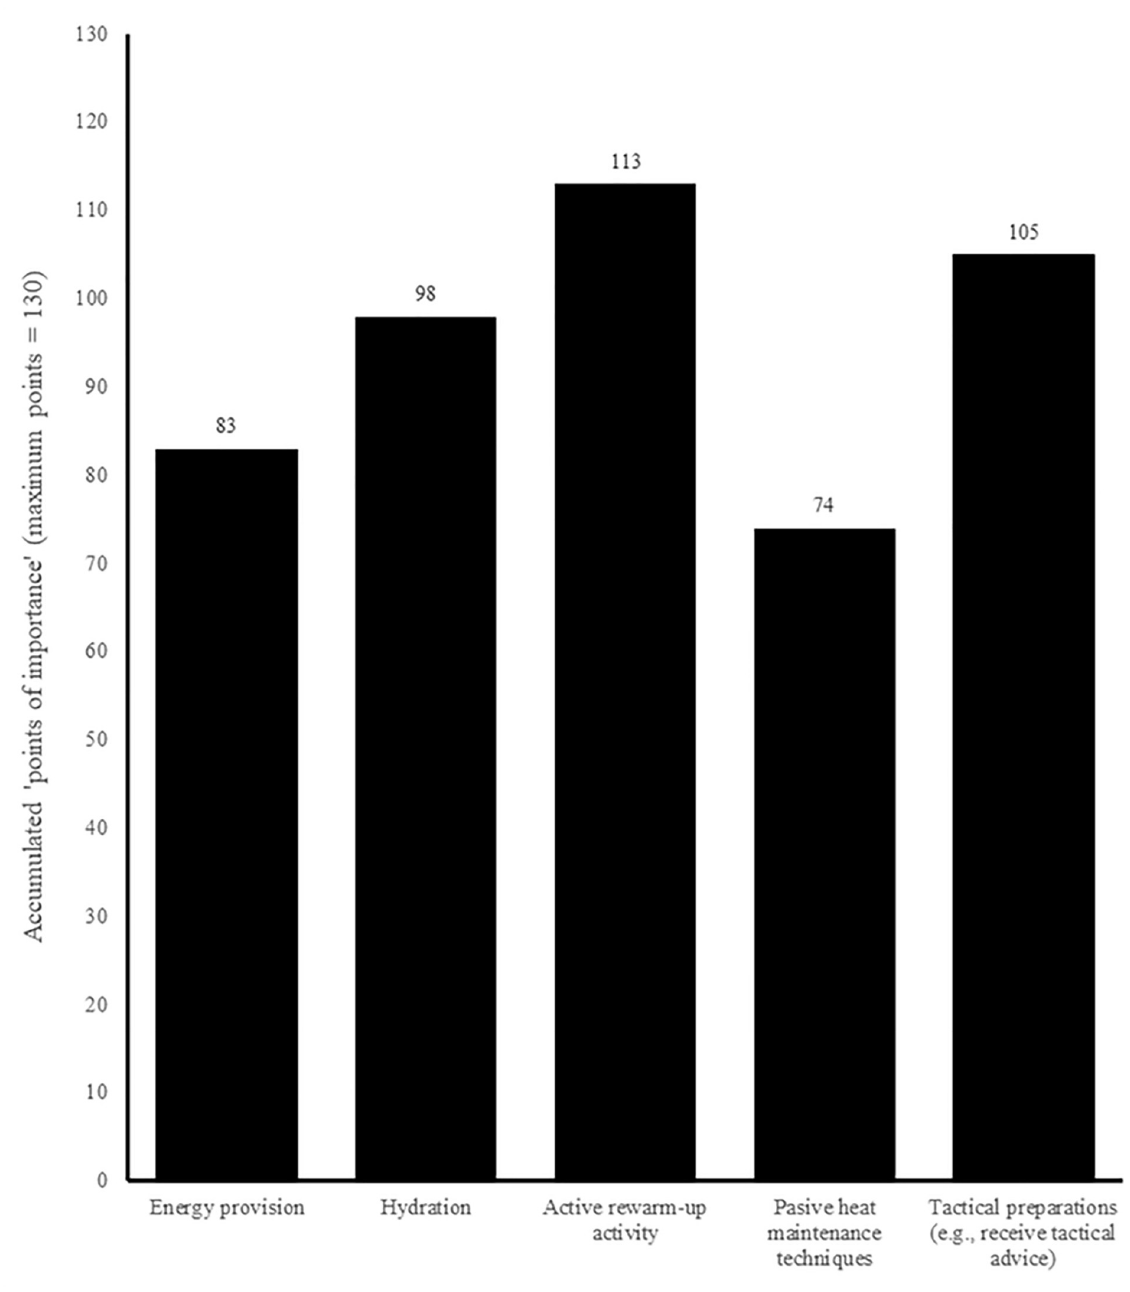
Fig 5. Physical practitioners’ perceived importance of preparatory strategies implemented between kick-off and pitch-entry (n = 26).